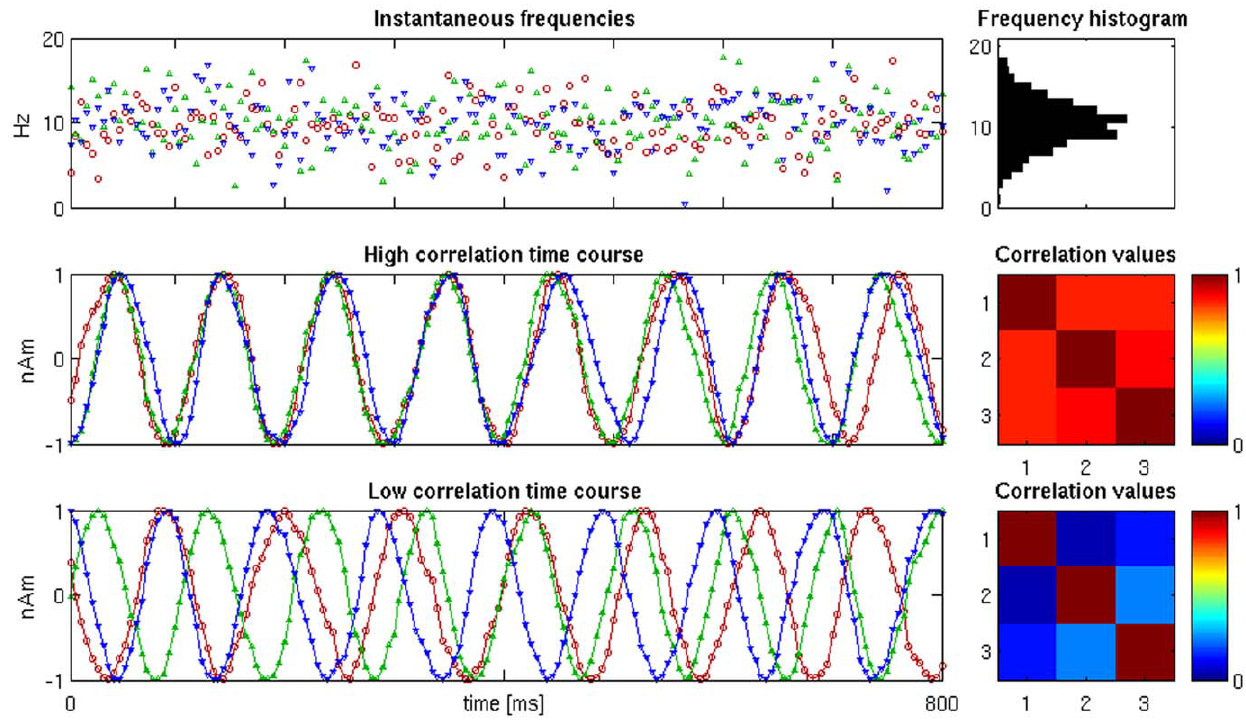
Figure 5. Synthetic time courses for one simulation. For each source, a frequency per time sample is drawn from a Gaussian distribution ( N (10 Hz ,3 Hz )) , top row). The instantaneous source amplitude is obtained by integrating the frequencies and taking the sine of the resulting angle. If the generated time course satisfies the desired correlation threshold (either high or low: middle and lower rows, respectively), it is accepted; otherwise the procedure is repeated. The corresponding frequency histogram and correlation matrices are shown in the right column.